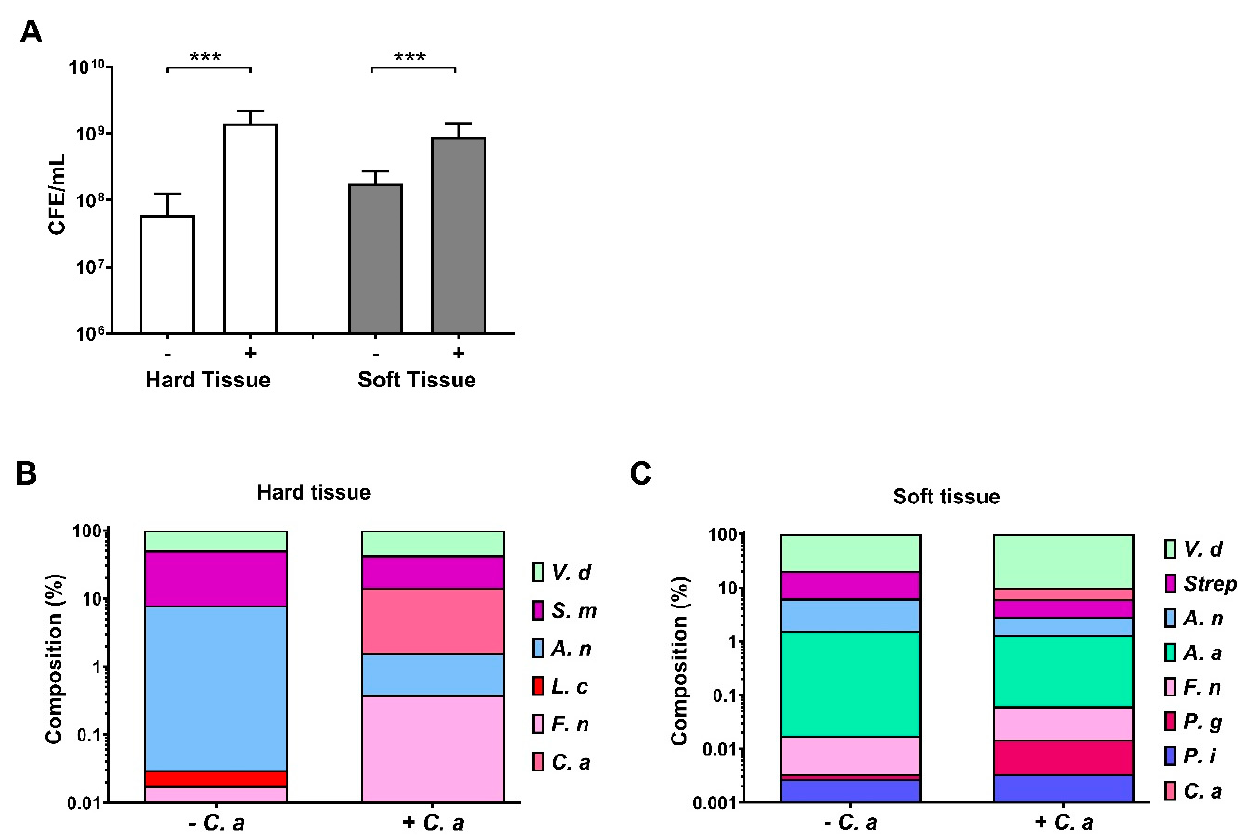
Figure 2. Bacterial load of hard tissue (HT) and soft tissue (ST) biofilms in the presence or absence C. albicans . Following growth and removal from the microtiter plate, DNA was extracted using the QIAamp DNA Mini Kit, and bacterial load assessed using 16s PCR. Fungal load was also determined using 18s PCR. The total bacterial load is shown in white bars for hard tissue and grey shaded bars for soft tissue ( A ). The 18s fungal counts were 4.4 × 10 7 and 6.2 × 10 6 CFE/mL for HT and ST biofilms, respectively. Further compositional analysis was carried out using species specific primers, as described in Table 1. HT biofilm composition is shown in ( B ) and ST biofilm composition represented in ( C ). Data represented as mean ± SD; n = 3 in three independent experiments. A Mann–Whitney t test was carried out to assess differences between means of bacterial load in biofilms containing C. albicans compared to without (*** p < 0.001).